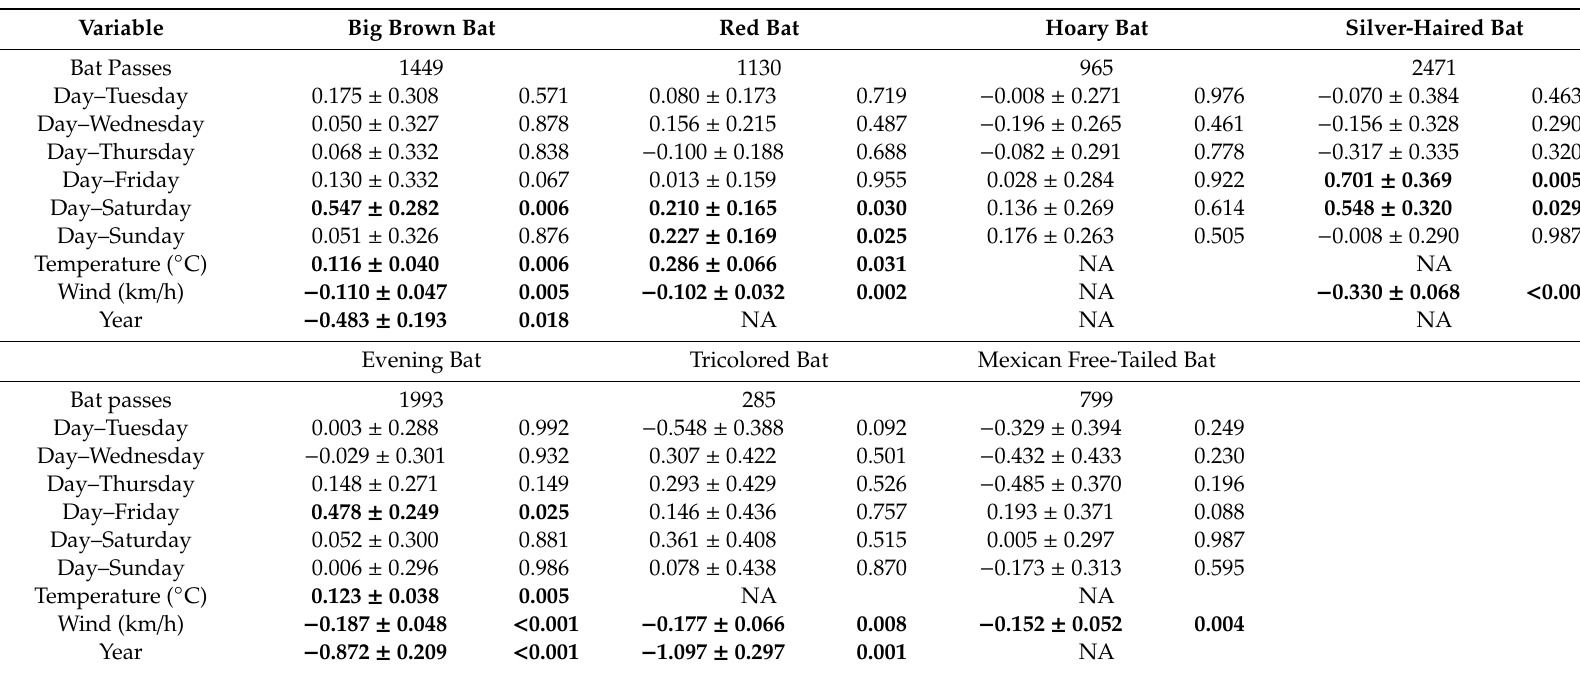
Table 3. Numbers of species-specific bat passes collected in 2018 and 2019 summers and generalized linear model results (species-specific bat passes versus day of the week and environmental covariates, regression estimate ± standard error and p value reported) at the Greensboro Science Center open site in Greensboro, North Carolina, USA. “NA” indicates variables dropped from the final model. Bold numbers indicate significant